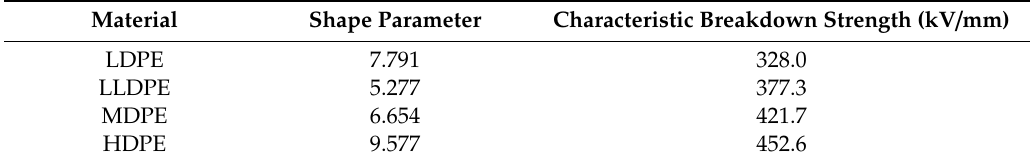
Table 2. Parameter and breakdown strength of